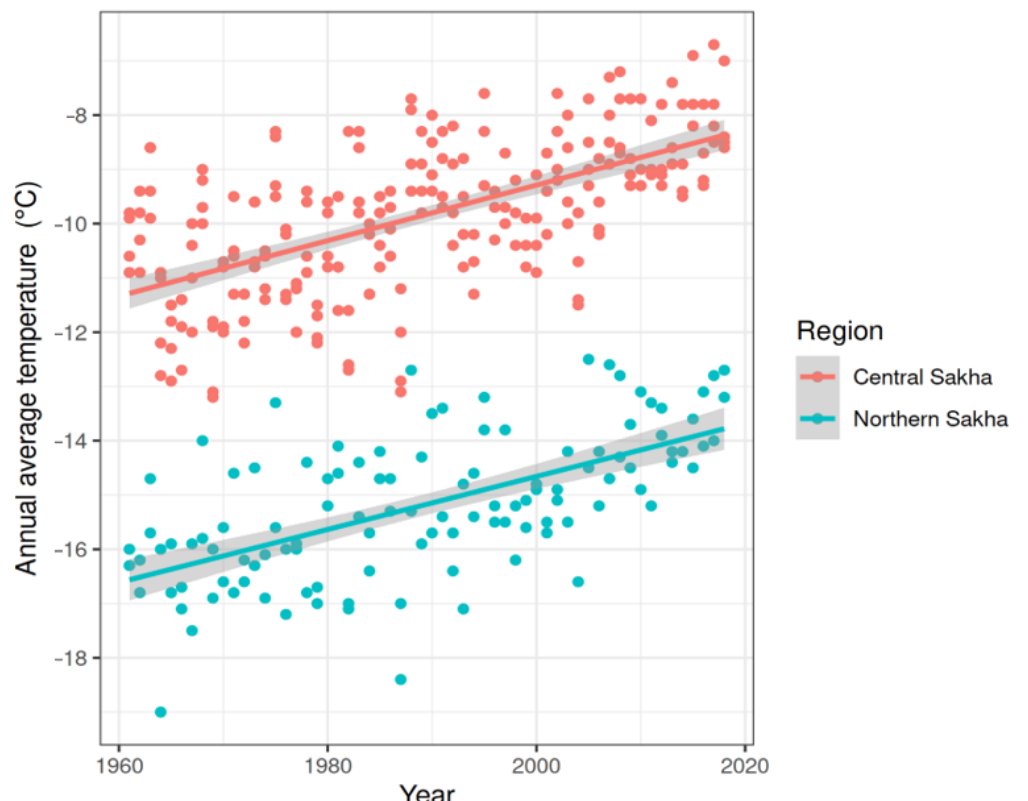
Figure 2. Time-series of the annual average temperature between 1961 and 2018, observed at 4 weather stations in central Sakha ( red ) and 2 weather stations in northern Sakha ( blue ). Solid lines are fitted linear regression lines, with 95% confidence intervals .